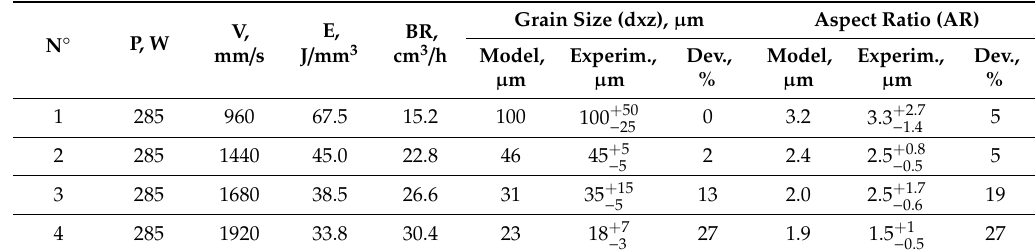
Table 6. Grain size (dxz) and grain aspect ratio ( t = 40 µ m; h = 110 µ m): model versus experiment [18]. N